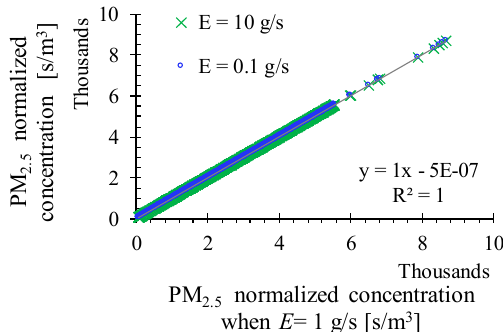
Figure 3. Comparison of the normalized PM 2.5 concentration at ground level obtained by AERMOD when the emission rate is 0.1 and 10 g / s against the normalized concentration when the emission rate is 1 g / s. Normalized concentration is obtained when the resulting concentration is divided by the emission rate in the source. Results were obtained for a burning area of 1 ha and the Minnesota meteorology dataset.